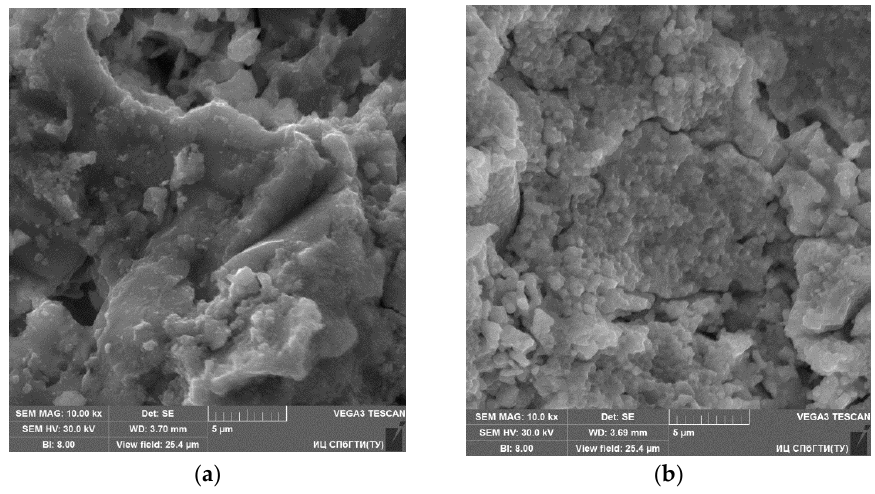
Figure 4. SEM images of ( a ) initial powder (annealed at 600 °C) and ( b ) ceramics (annealed at 1300